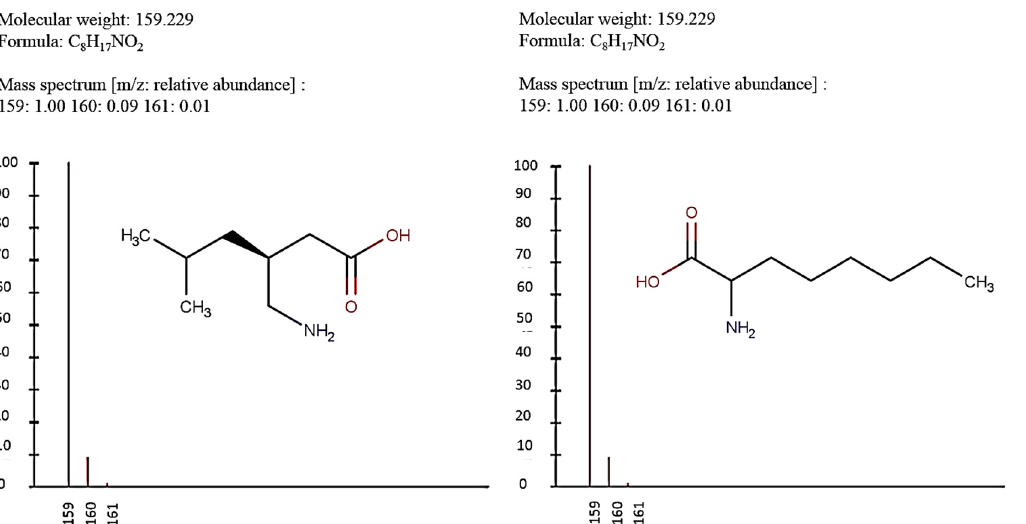
Figure 4. Elemental analysis of pregabalin ( left ) and DL-2-aminooctanoic acid ( right ), generated using Marvin Sketch.